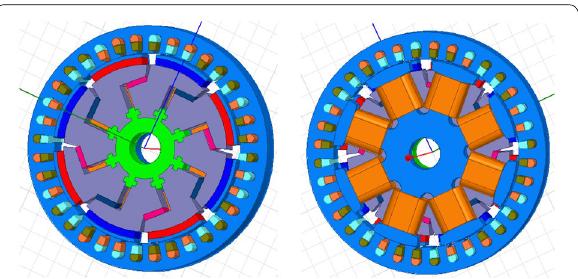
Figure 14 Three-dimensional model of double-radial permanent magnet and salient-pole electromagnetic hybrid excitation